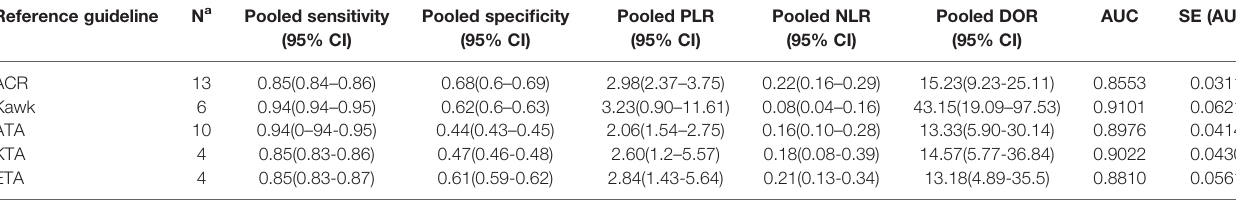
TABLE 2 | Pooled estimates of the sensitivity, speci fi city, PLR, NLR, DOR, AUC, and SE (AUC). Reference